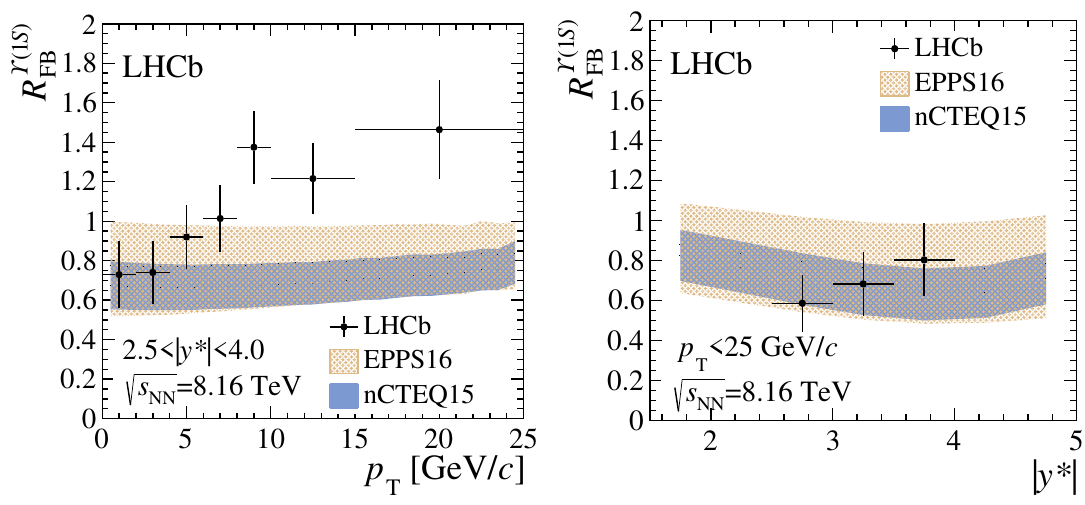
Figure 8 . Forward-backward ratio for the (cid:7) (1 S ) as a function of (left) p T integrated over y (cid:3) and (right) as a function of j y (cid:3) j integrated over p T . The bands correspond to the theoretical calculations for the nCTEQ15 and EPPS16 nPDFs sets as reported in the text.